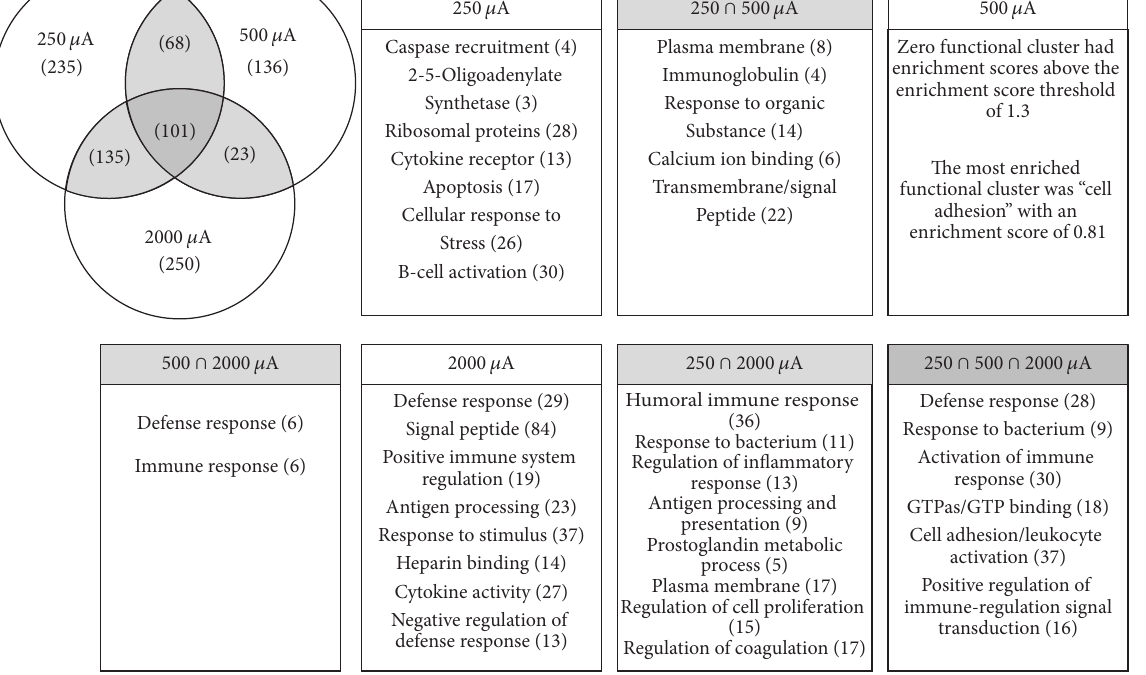
Figure 2: Highly enriched terms from DAVID’s Bioinformatics functional clustering with total number of genes listed in parentheses. Listed in parentheses is the number of genes induced by each current stimulation only (250 𝜇 A only, 500 𝜇 A only, and 2000 𝜇 A